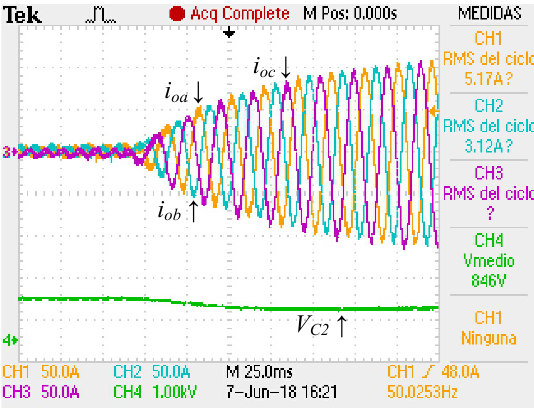
Figure 15. PCC o currents and V C 2 .